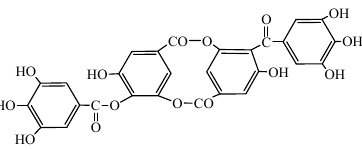
Figure 1. Typical molecule structure of tannin in valonea extract.